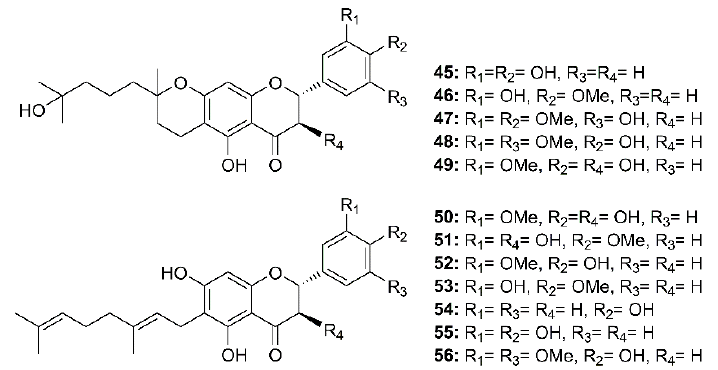
Figure 7. Structures of quercetin-3- β - D -galactoside ( 36 ) and its synthetic derivatives 37 – 44 . Twelve geranylated flavonoids, including tomentins A–E ( 45-49 ), 3 ′ - O -methyl- diplacol ( 50 ), 4 ′ - O -methyldiplacol ( 51 ), 3 ′ - O -methyldiplacone ( 52 ), 4 ′ - O -methyldiplacone ( 53 ), mimulone ( 54 ), diplacone ( 55 ) and 6-geranyl-4 ′ ,5,7-trihydroxy-3 ′ ,5 ′ -dimethoxyfla-